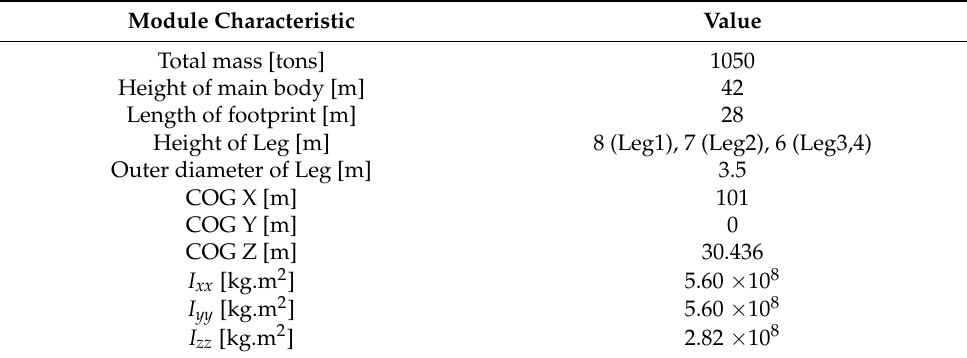
Figure 3. Numerical model of the lowering system of the jacket in AQWA (top view). Table 1. Main parameters of the jacket platform.